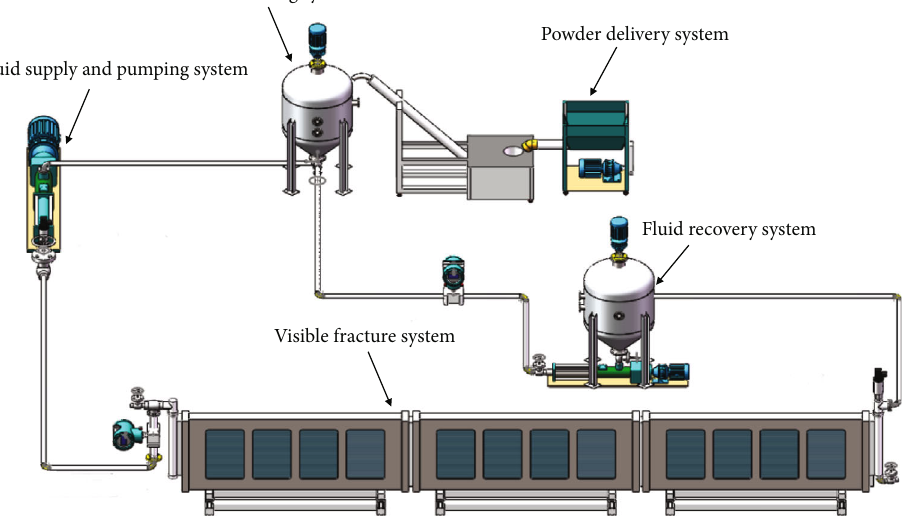
Figure 2: The technological process of an experimental device for visualization of fl ow state in proppant-supported fracture.